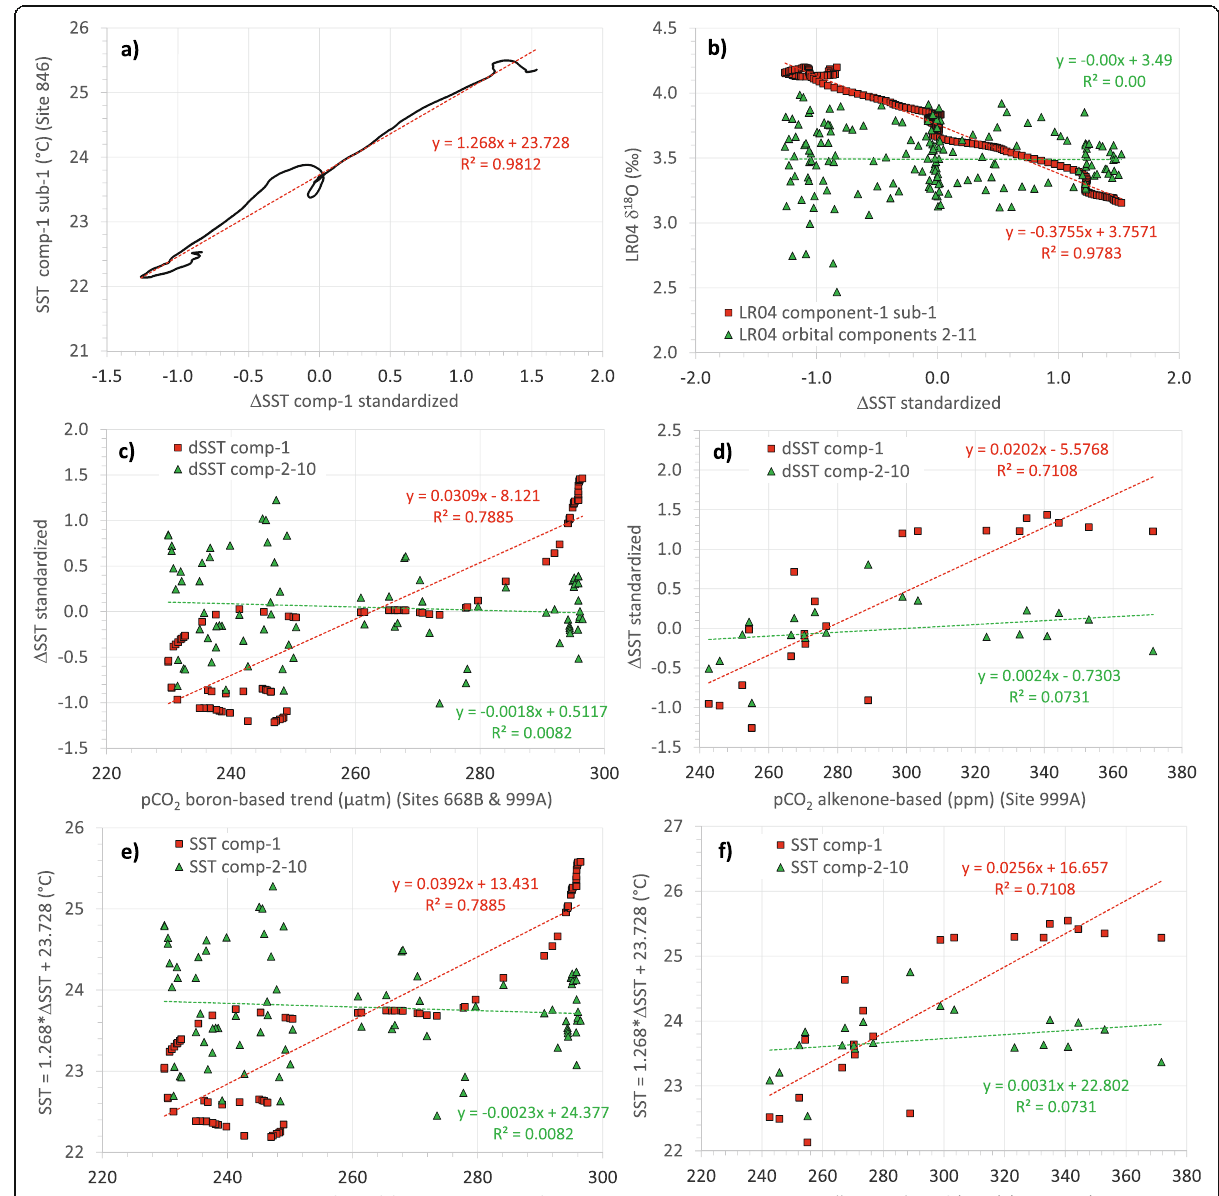
Fig. 13 Late Pliocene-Pleistocene cross plot between trend components of global Δ SST stack and tropical SST at Site 846 ( a ). Cross plots between the Δ SST stack (°C by means of Δ SST stack and b δ 18 O, c boron-based, and d alkenone-based pCO 2 SSA-components. Cross plots between the converted the function in a ) and e boron-based pCO 2 and f alkenone-based pCO 2 trends. The long-term trend components are clearly linked, whereas orbital components are unrelated to the long-term trends. Proxy data: composite atmospheric boron-based pCO 2 proxy from ODP Sites 668B-999A (Hönisch et al. 2009; Bartoli et al. 2011), atmospheric alkenone-based pCO 2 and SST proxies from ODP Site 999A (Seki et al. 2010), alkenone-based SST proxy from ODP Site 846 (Herbert et al. 2010b), LR04 δ 18 O stack (Lisiecki and Raymo 2005b), and global Δ SST stack (Martinez-Boti et al.